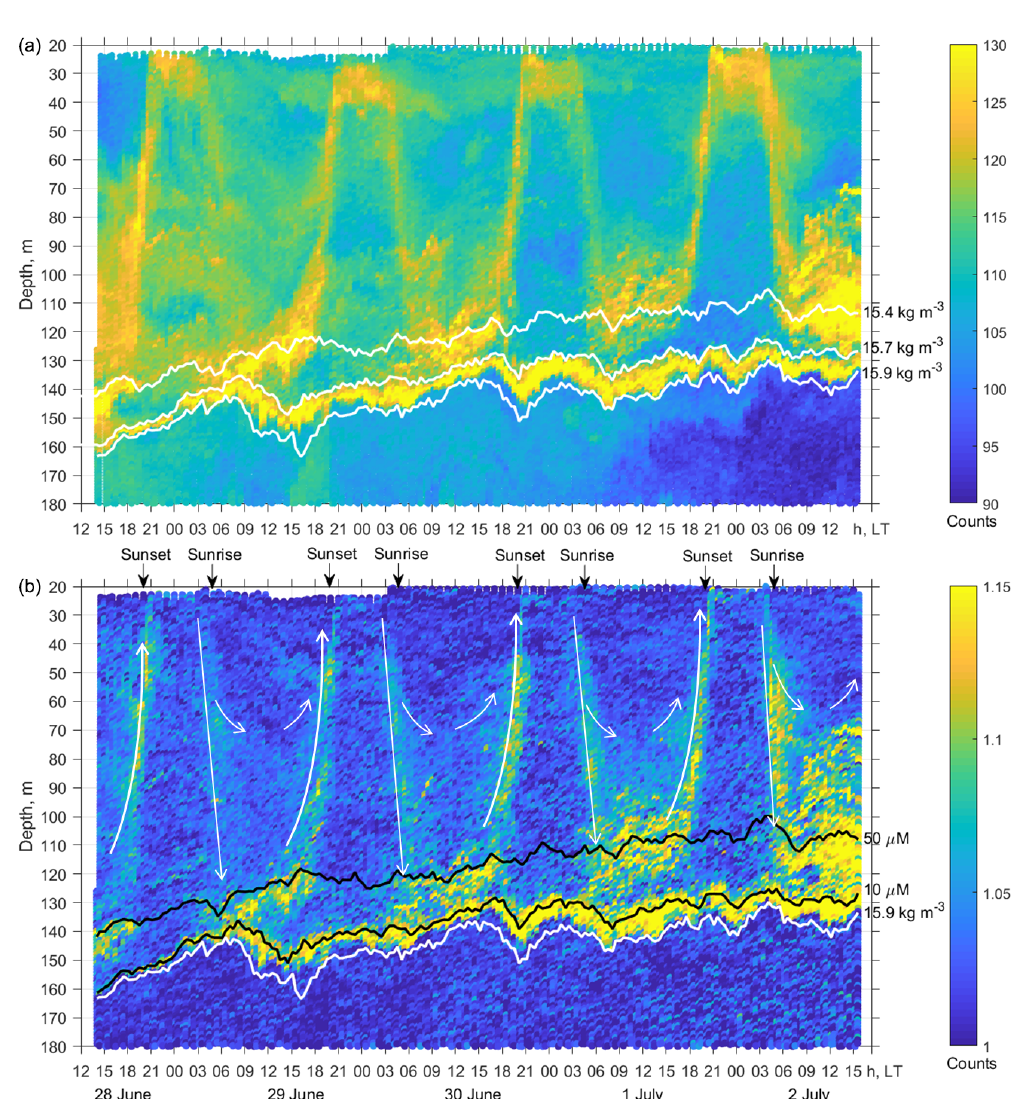
Figure 9. (a) The time–depth graph of the Aquadopp horizontal-beam echo (A 1 + A 2 )/ 2 during the moored profiler survey on 28 June–2 July 2014. The isopycnals are superimposed near the SSLs. (b) The graph of time–depth variation in R based on the measurements of sound backscattering. The upper and lower black lines are isooxylines of 50 and 10µm, respectively. The white line indicates isopycnal σ (cid:50) = 15.9. There is a persistent SSL under isooxyline [O 2 ] = 10µm. Thin white arrows schematically show the diel migration of mesozooplankton. The maximum depth of the diel vertical migration is 120–150m, although some specimens dive to depths of only 80–100m. The slope of the straight arrow pointing downwards corresponds to a diving speed of ∼ 1.5cms − 1 . The ascent is accelerated and reaches values of approximately 2.5cms − 1 in the upper 60m